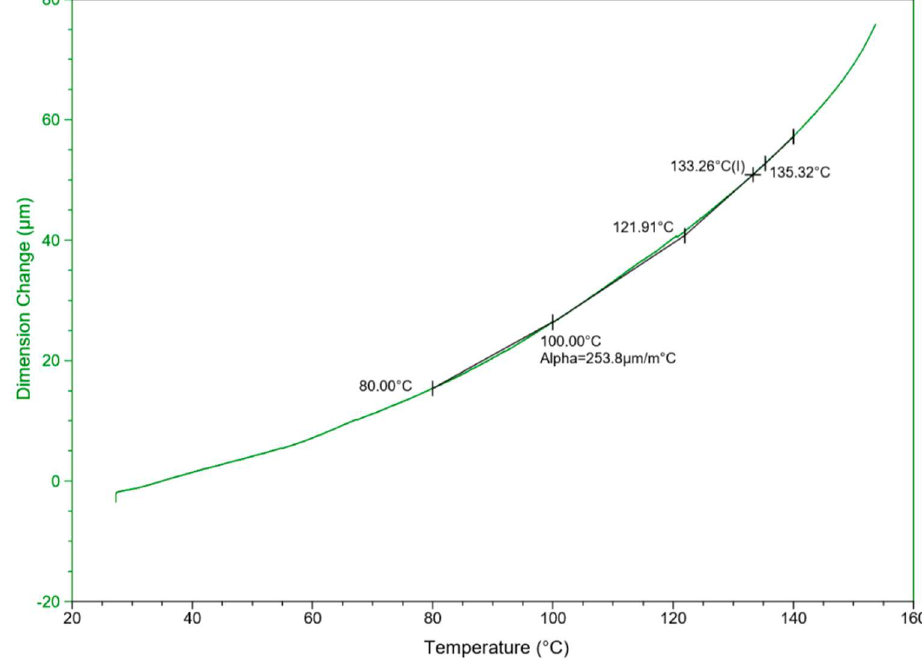
Figure 5. Typical thermomechanical curve for PVDF–SSPF showing the linear expansions based on temperature T (°C) and dimension change (µm).